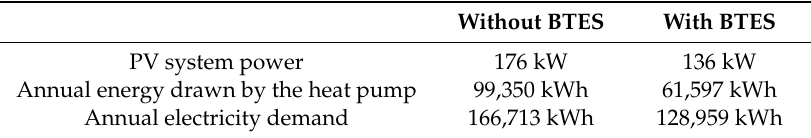
Table 8. Benefits of BTES technology for the school